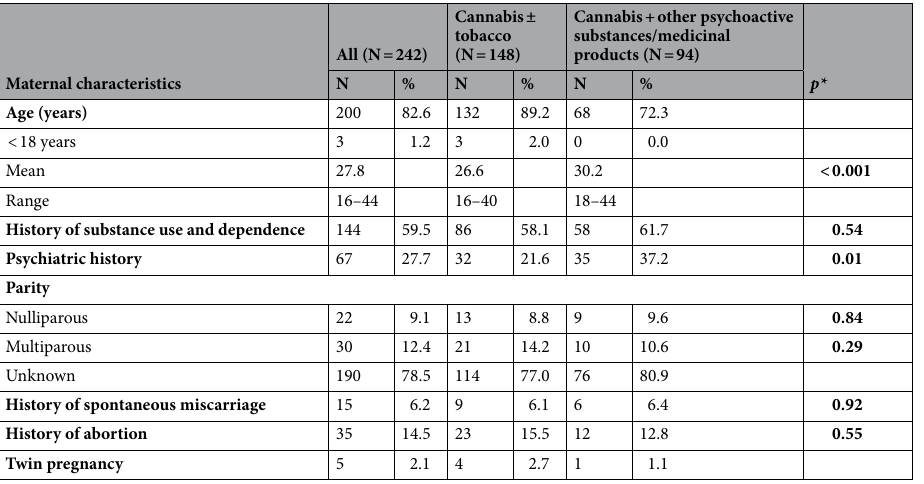
Table 1. Characteristics of cannabis pregnant users. *p value derived from Chi-square test for comparison of proportions and Student test for comparison of means. Significant values are in